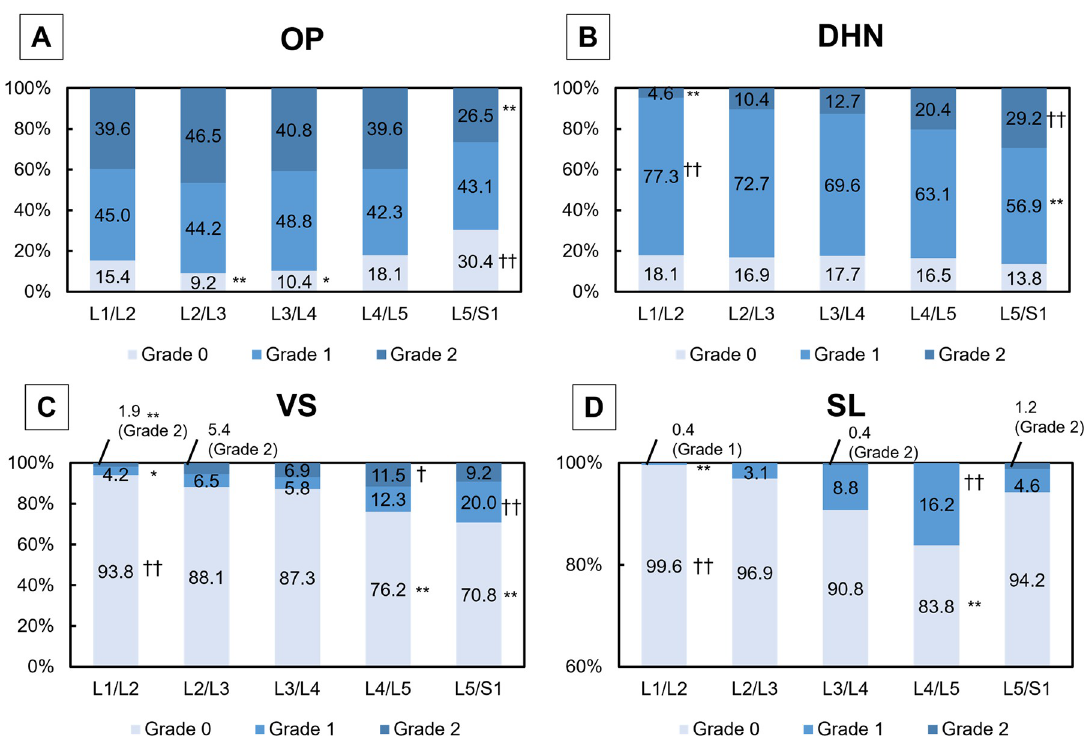
Fig 2. Distribution of radiographic features of lumbar spondylosis. Data are expressed by the percentage of intervertebral levels. A: osteophyte (OP), B: disc height narrowing (DHN), C: vertebral sclerosis (VS), D: spondylolisthesis (SL). Chi-square test showed significant differences among intervertebral level in all radiographic features (P < 0.01). � indicates significantly lower than expected ( � P < 0.05, �� P < 0.01) and † indicates significantly higher than expected (†P < 0.05, ††P < 0.01) (by Bonferroni